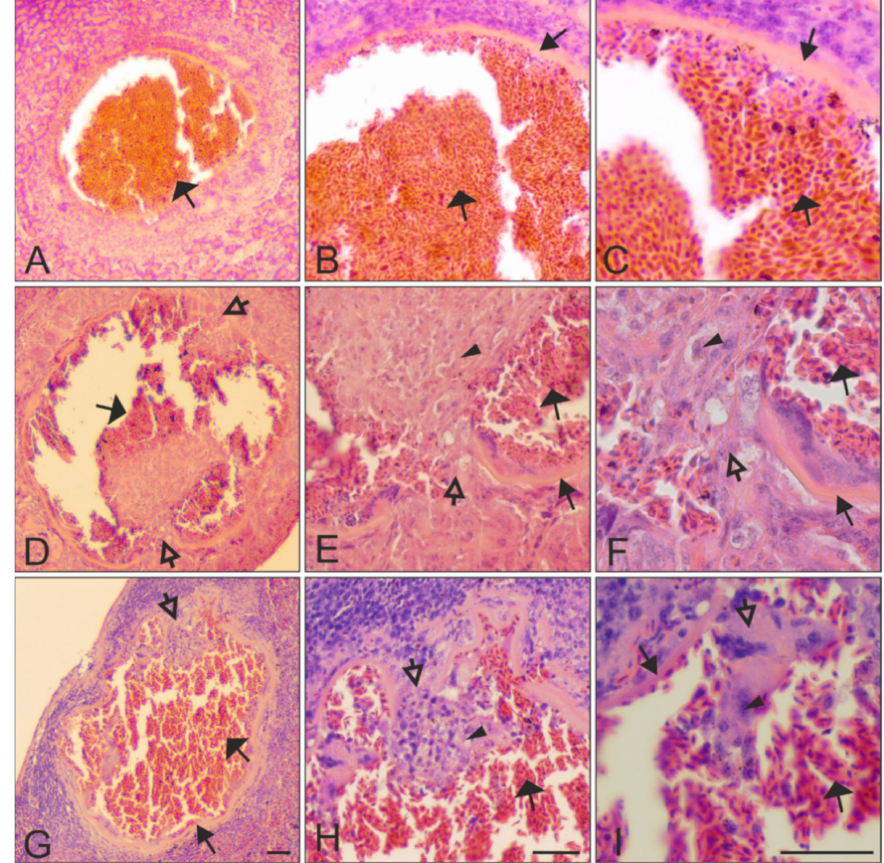
Figure 5. Ruptured mature megalomeronts of Haemoproteus pastoris (lineage hLAMPUR01) in the pancreas ( A – C ), the intestine ( D – F ), and the spleen ( G – I ) of naturally infected Common starlings Sturnus vulgaris . Note that the prominent capsular-like wall was still present after megalomeront maturation and release of merozoites ( B , C , E – I ), resulting in maintenance of a prominent space, which was invaded with numerous erythrocytes and other blood cells ( A – C vs. D – I ). Parasites were shown at three different magnifications: A, D, G × 100; B, E, H × 200, and C, F, I × 400. Filled-black triangle arrows ( )—capsular-like wall. Contoured-black triangle arrows ( )—rupture of the capsular-like wall. Flat triangle arrows ( )—red blood cells invading the megalomeront. Triangle arrowheads ( )—other cells invading the megalomeront. All scale bars = 40 µ